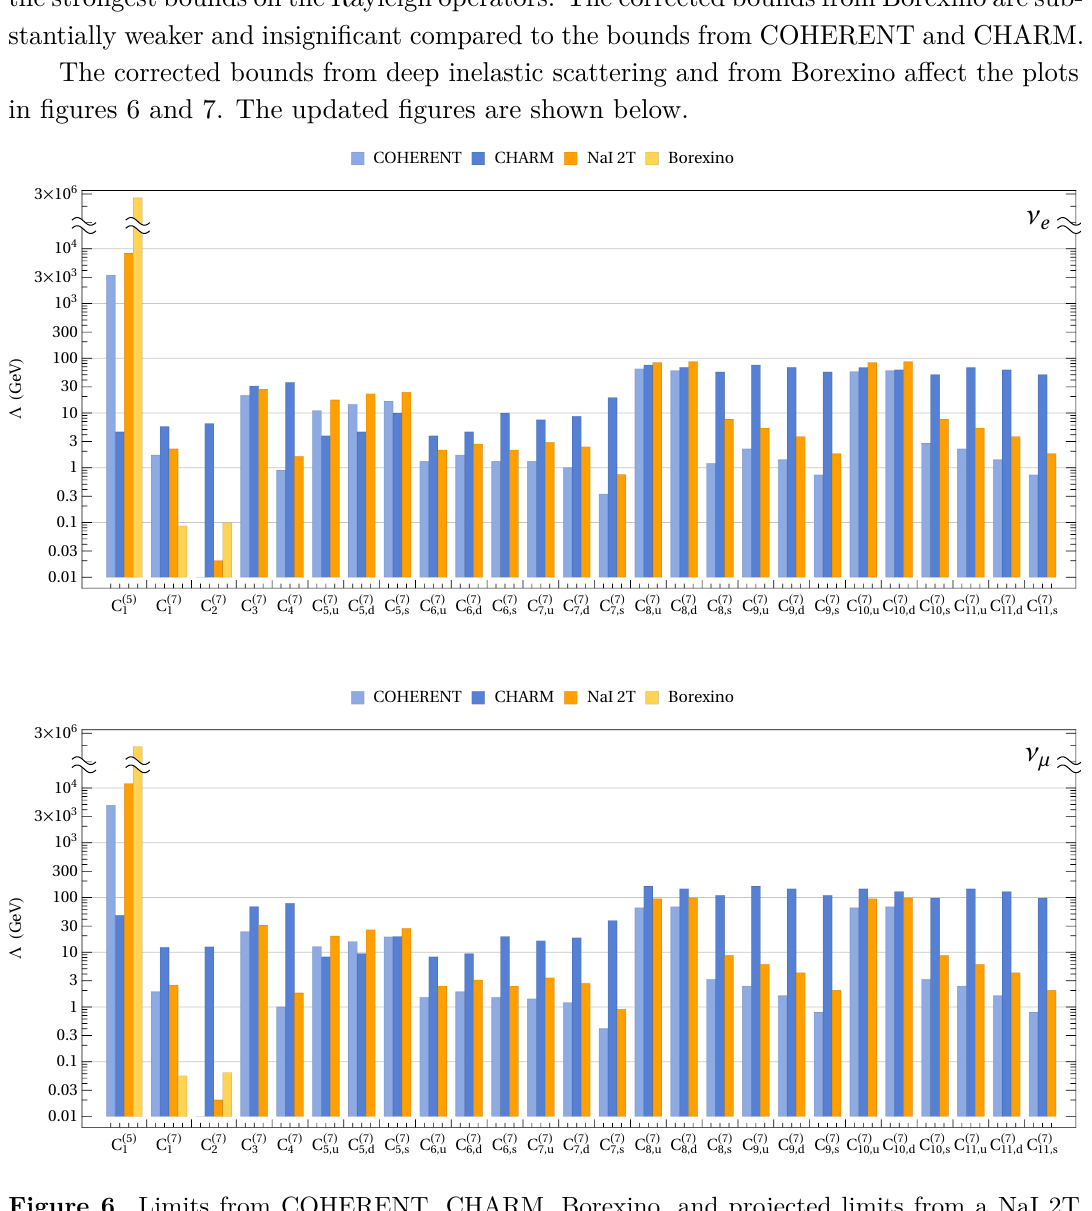
Figure 6 . Limits from COHERENT, CHARM, Borexino, and projected limits from a NaI 2T experiment on the scale Λ of dimension 5 and dimension 7 NSI operators for electron neutrinos (top) and muon neutrinos